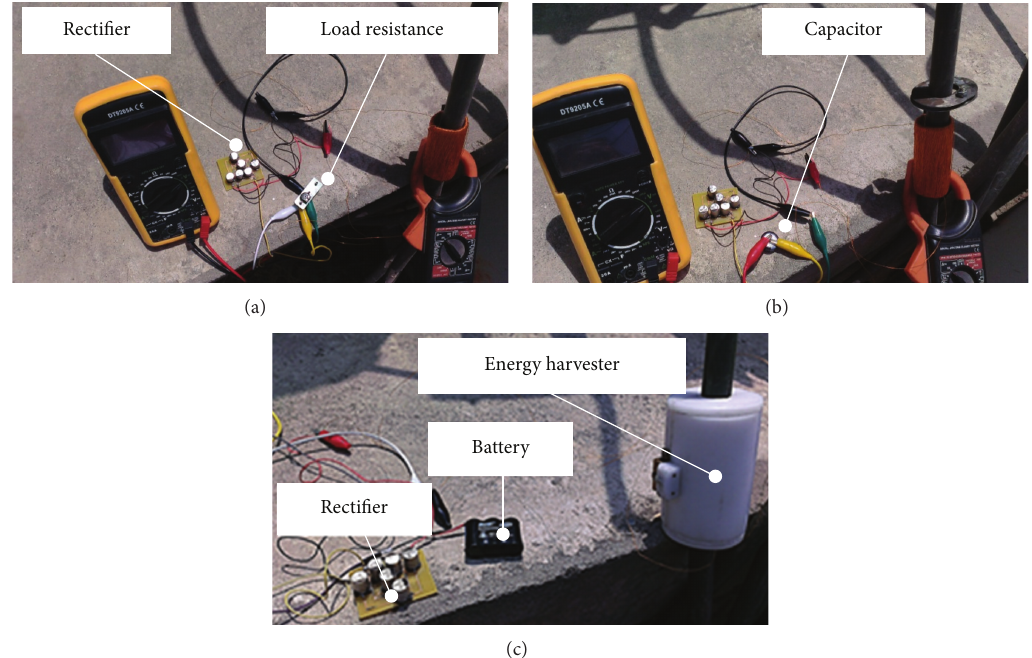
Figure 21: Photographs during voltage rectification and charging: (a) inductive energy harvester connected to a rectifier, (b) charging of a super capacitor with a harvester’s rectified voltage, and (c) charging of a rechargeable battery with a harvester’s rectified voltage.